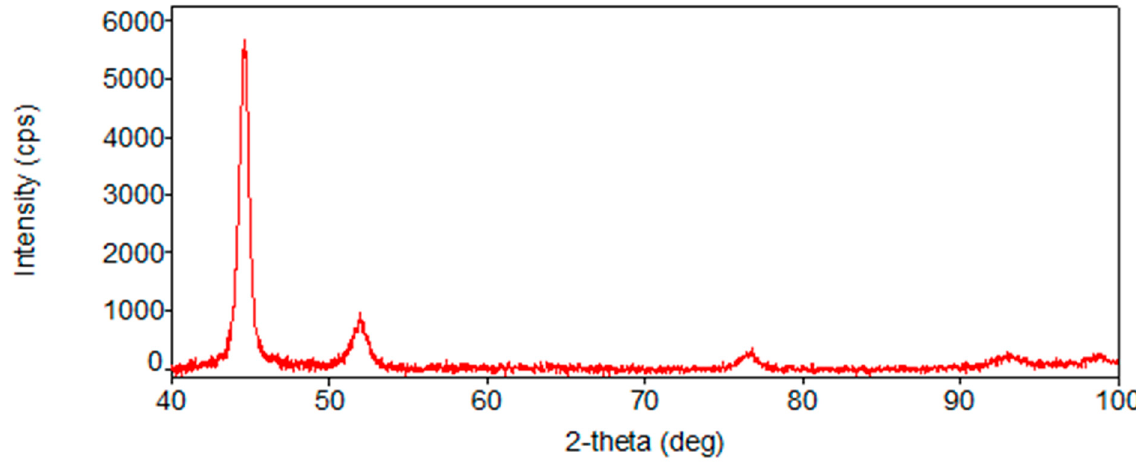
Figure 2. XRD pattern of the nickel catalyst.